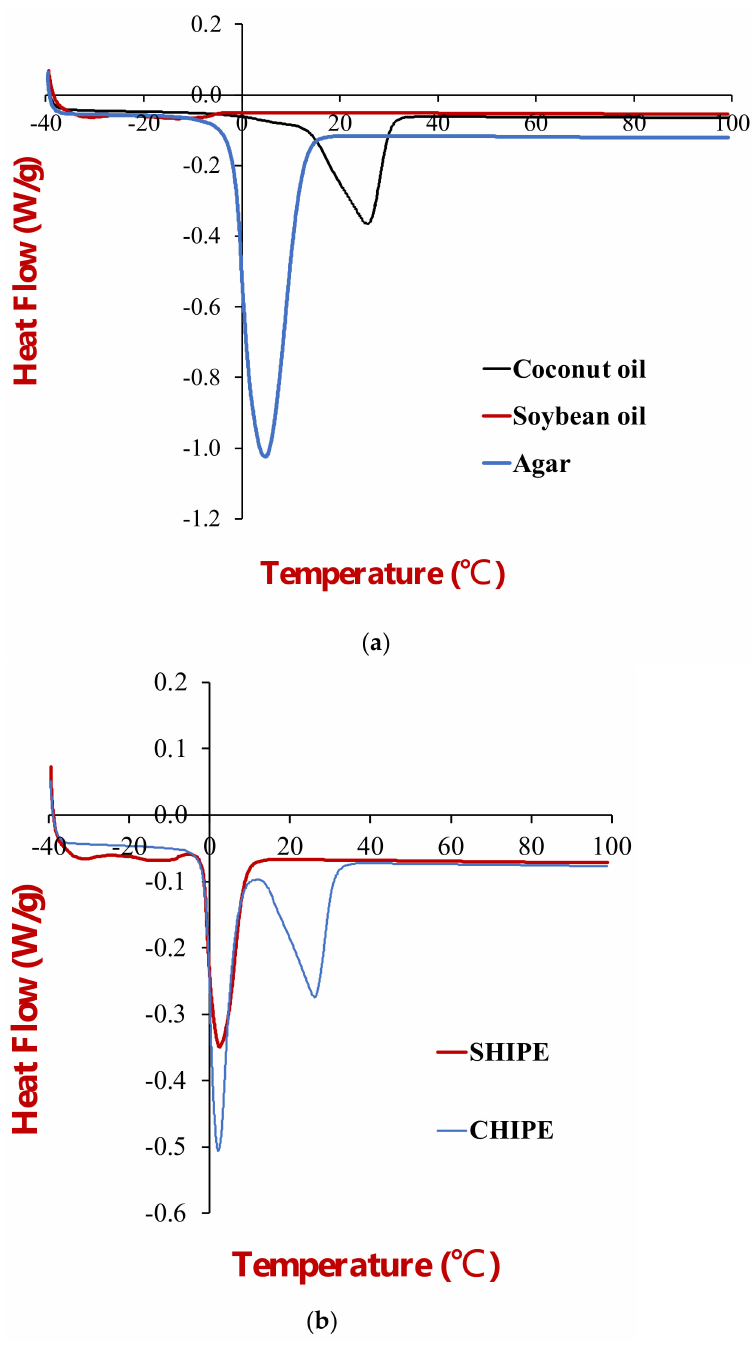
Figure 8. ( a ) DSC profiles of coconut oil, soybean oil, and agar when they were heated from − 40 to 100 ◦ C. ( b ) DSC profiles of coconut oil HIPES (CHIPE) and soybean oil HIPEs